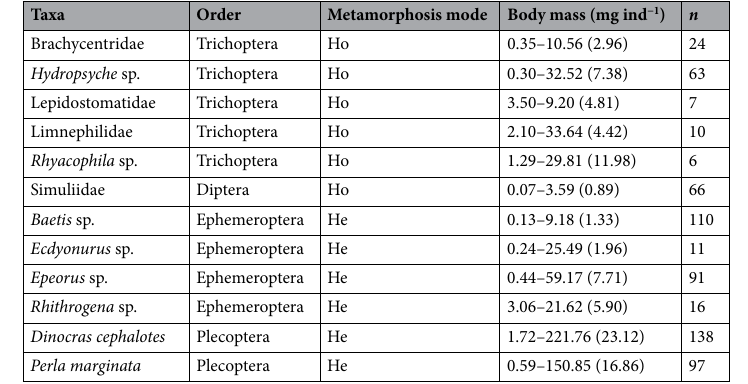
Table 1. Aquatic insects used in the nucleic acid analyses in this study. Metamorphosis mode: (Ho) holometabolous, (He) hemimetabolous. Body mass: Range of animal body mass; medians are shown in parenthesis. n : Number of samples for nucleic acid measurements in this